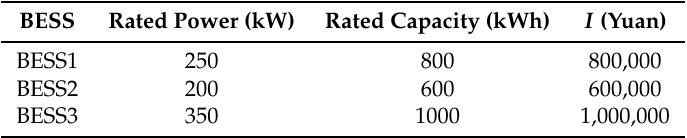
Table 5. Parameters of the